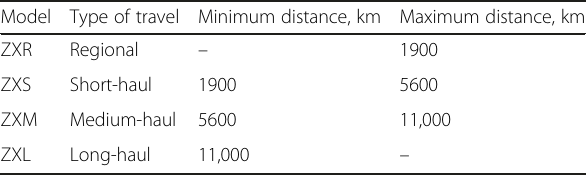
Table 3 When data is missing from EEA, approximations are done according to assumptions on travel distances for regional, short-haul, medium-haul, and long-haul distances Model Type of travel Minimum distance, km Maximum distance, km